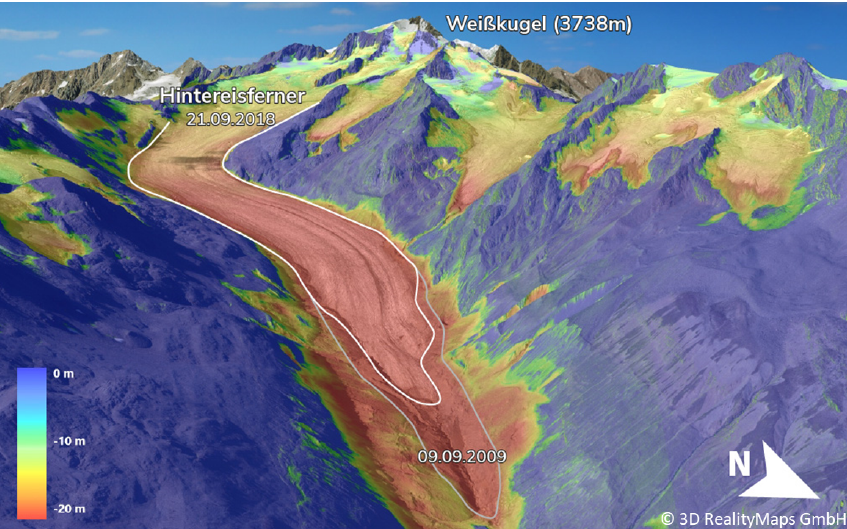
Figure 4. Three-dimensional representation of the color-coded height differences in meter (m) between the DSMs of September 2009 and September 2018 for Hintereisferner (white outline). Surface elevation loss appears in red; constant elevation appears blue. Ice loss is especially high at altitudes below 2500m. The underlying orthophoto was derived from the 2018 aerial survey. Height loss in the southeast of the glacier tongue can likely be attributed to an existing dead-ice